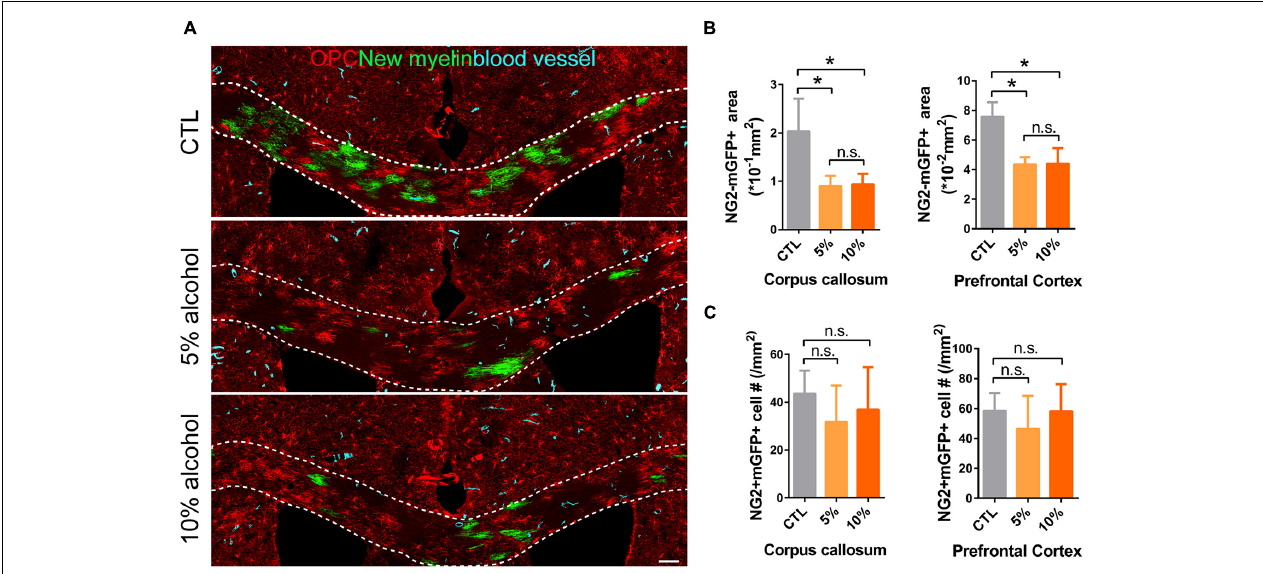
FIGURE 3 | Myelin generation is inhibited by chronic alcohol exposure in adult mice. (A) Representative images of OPCs (red), newly formed OLs (green) and blood vessels (cyan) showing remarkably decreased myelin generation in alcohol treated groups. Scale bar 100 µ m. (B) Quantification of NG2-mGFP + myelin area in the corpus callosum and prefrontal cortex. [* p < 0.05, n.s. Tukey (5 vs. 10%) p = 0.99 and 0.99, n = 6] (C) Quantification of NG2 + mGFP + cells in the corpus callosum and prefrontal cortex (n.s. p = 0.46 and 0.49, n = 5).